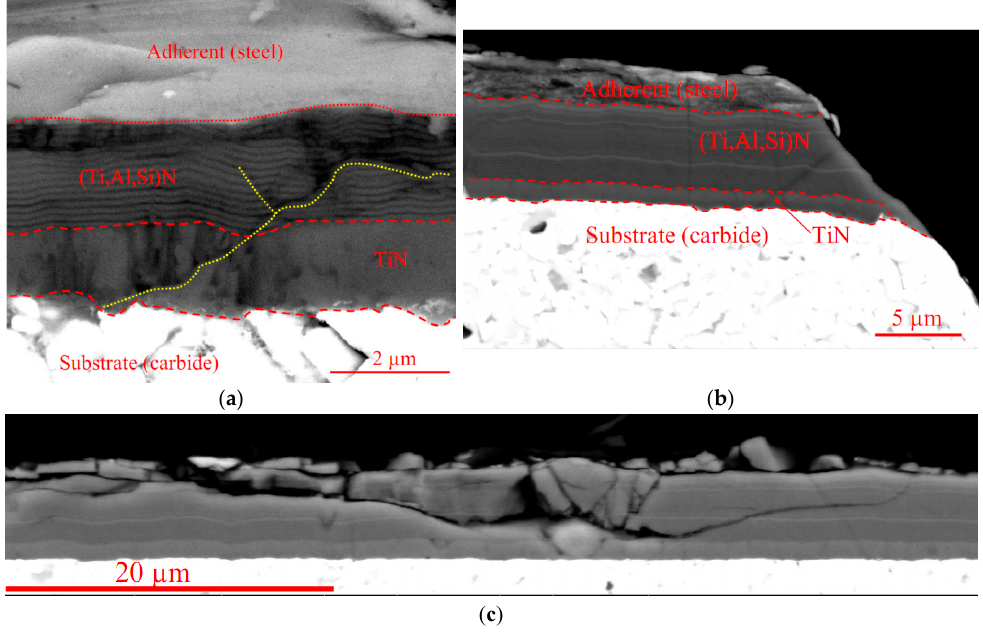
Figure 19. Mechanism of wear and failure for cutting tool with coating S3 ( a ) and S4 ( b , c ).